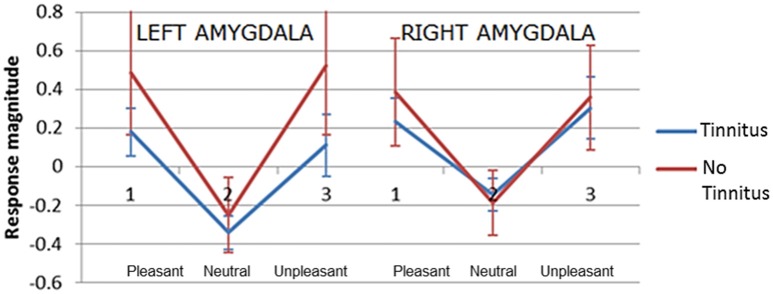
Plots of mean response magnitude (beta values p < 0.05, uncorrected) for the left and right amygdala across three categories of pleasantness (1) pleasant (2) neutral (3) unpleasant. Error bars represent 95% confidence intervals.